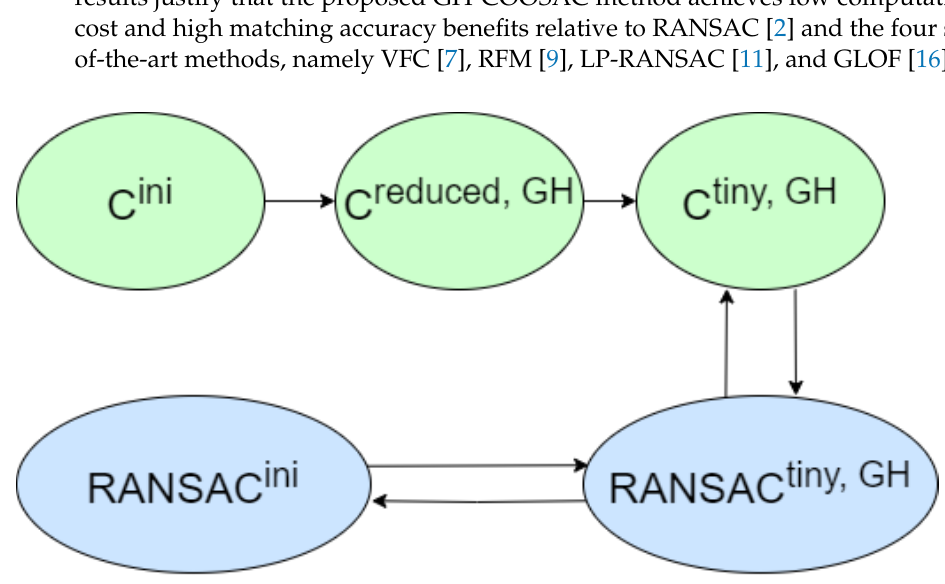
Figure 1. The sketched flow diagram of the proposed GH-COOSAC